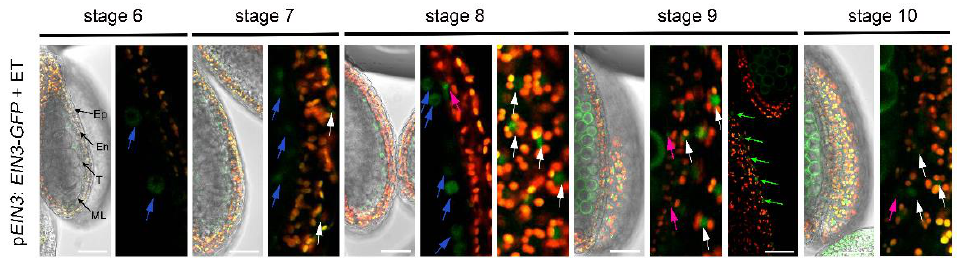
Figure 8. The expression pattern of EIN3 in anthers after ethylene treatment. Fluorescence images of the p EIN3 : EIN3-GFP in anthers. The green channel showed the GFP signal and the red fluorescence channel showed auto-fluorescence of chlorophyll in epidermal and endothecium. The blue, white, and red arrows indicate the GFP signal in the nuclei of tapetum, epidermis and endothecium, respectively. The green arrow indicate the GFP signal in the nuclei of filament. Ep: epidermis; En: endothecium; ML: middle layer; T: tapetum. Bars = 30 μm.